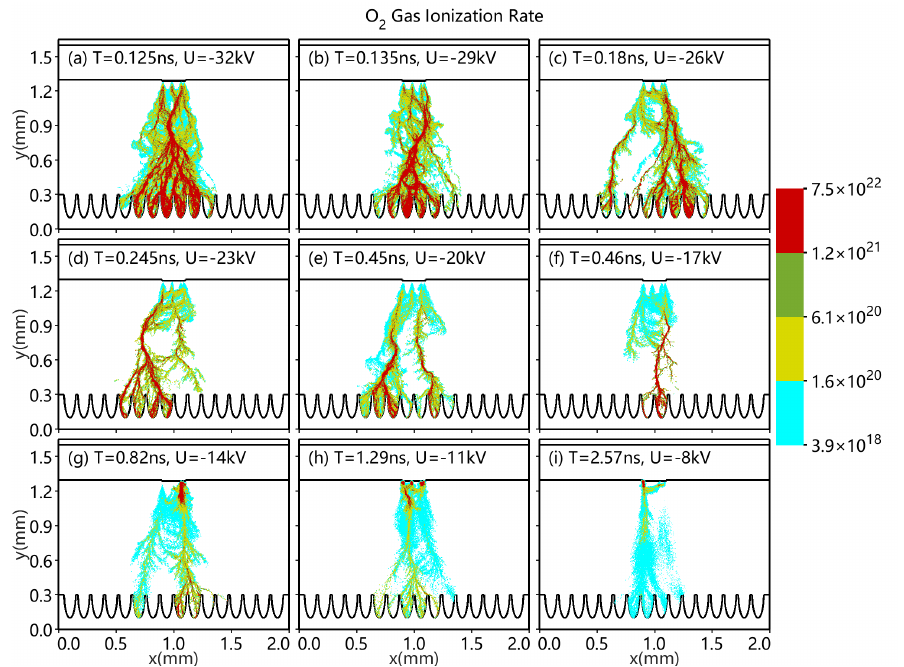
Figure 6. Distributions of the electron-impact O 2 ionization rates (m − 3 s − 1 ) for different voltages in DBD with ε r = 4 for both the top and bottom dielectric plates. The bottom dielectric plate has 16 pores. The diameter and depth of the catalyst pore are 0.1 mm and 0.2 mm, respectively. The voltage of the upper electrode ( y ∈ [ 1.60,1.65 ] mm) varies from − 8 kV to − 32 kV, and the bottom electrode ( y = 0 mm) is grounded.